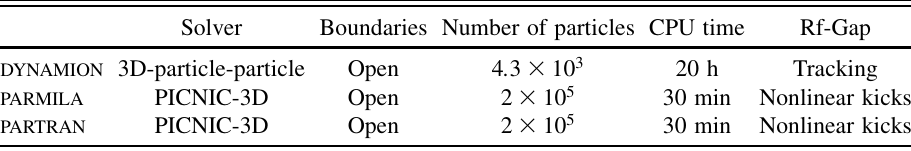
TABLE II. Summary of the properties of the simulation codes. Solver